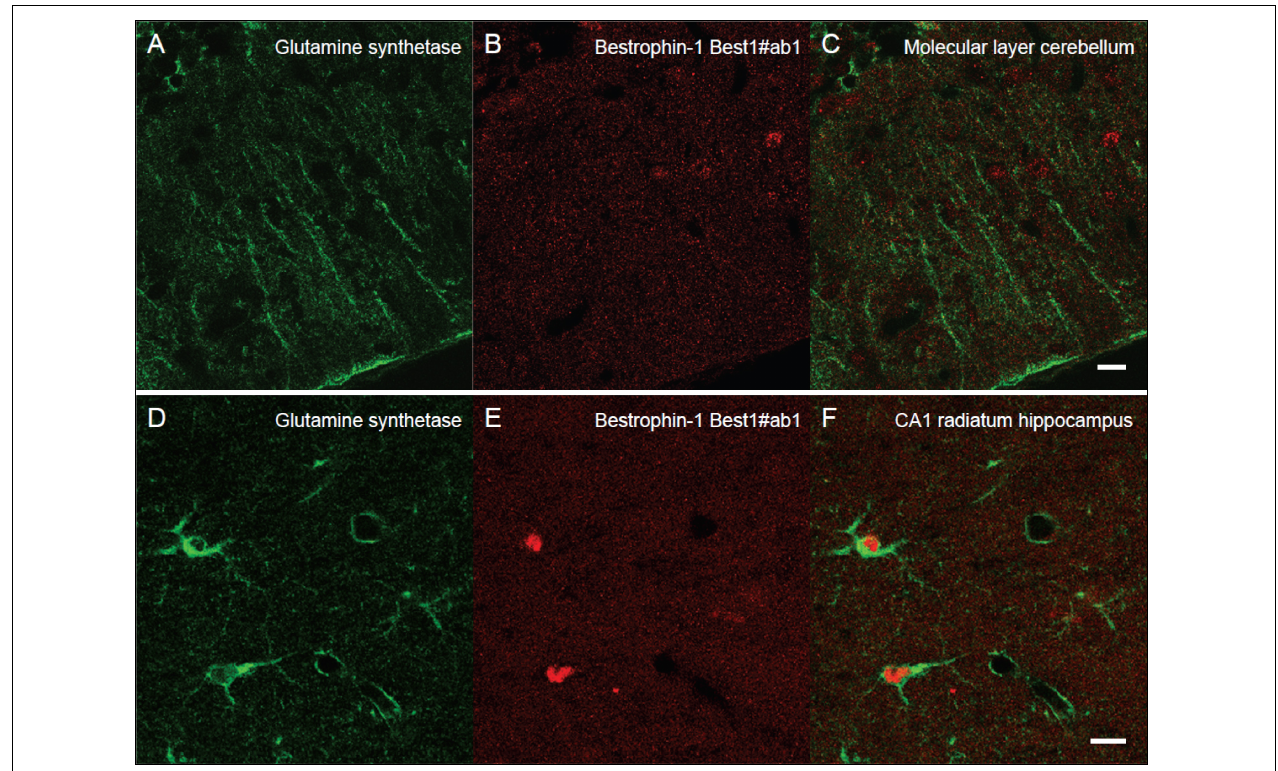
FIGURE 3 | Lack of clear bestrophin-1 immunosignal in Bergman glia and CA1 hippocampal astrocytes. Confocal micrographs showing double labeling for glutamine synthetase (green, A,D ) and for bestrophin-1 using the Best1ab#1 (red, B,E ) in the cerebellar molecular layer (A–C) and the hippocampal CA1 stratum radiatum (D–F) of C57BL/6 mice. There is some nuclear bestrophin-1 staining (unspecific), but no clear bestrophin-1 staining of astroglial cytoplasm (overlay in C,F ). Scale bars, 10 µ